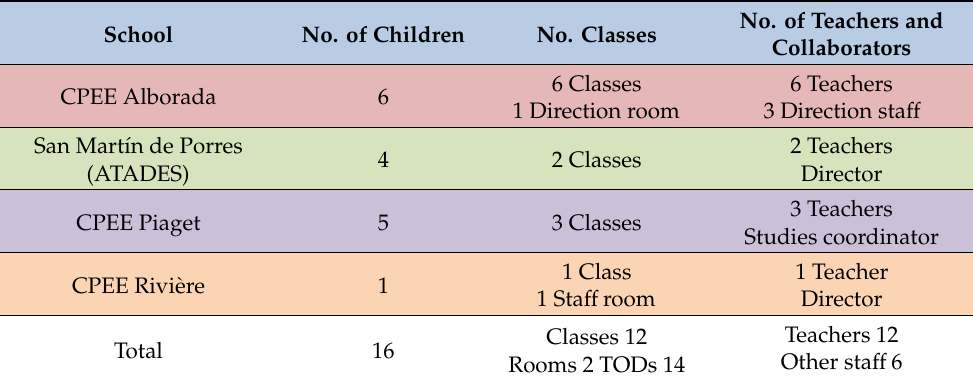
Table 1. Participants per school and